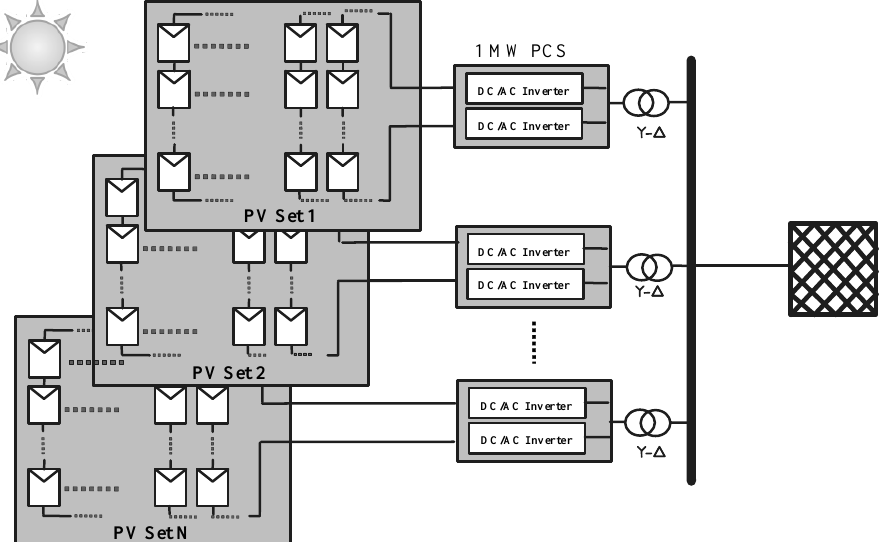
Figure 2. A grid scale PV-based generation unit.